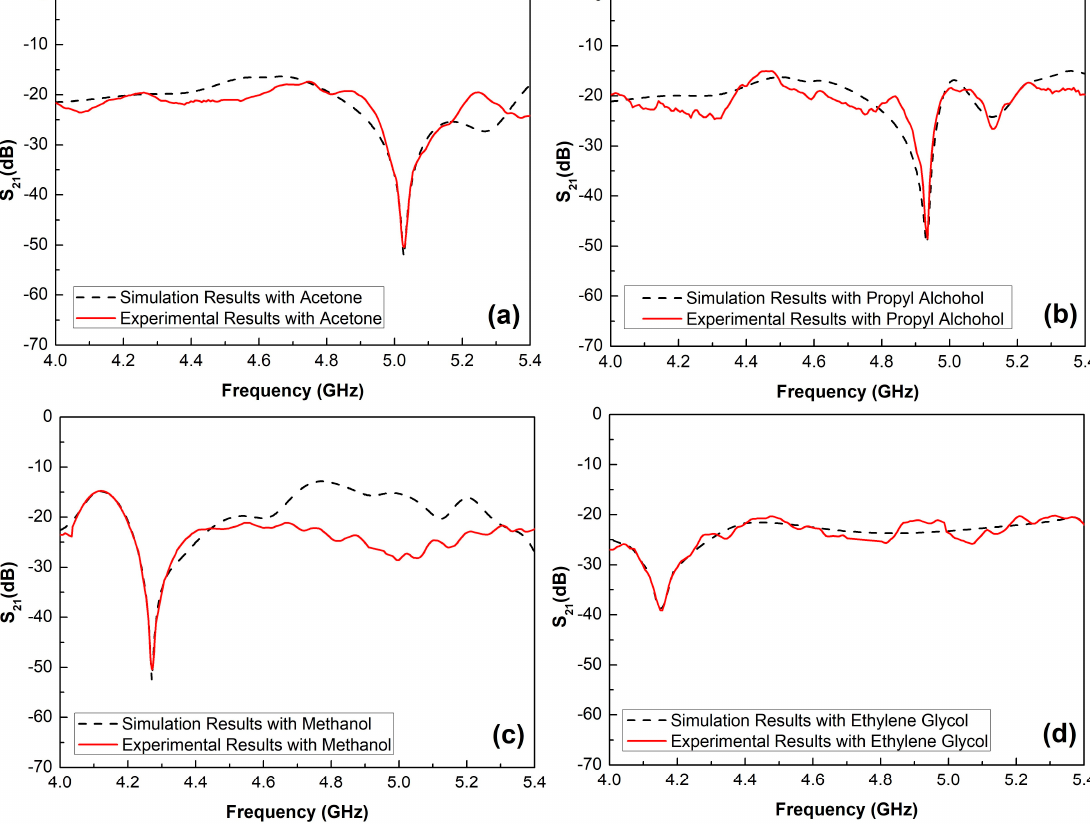
Figure 3. Simulated and experimental results obtained for ( a ) Acetone ( ε = 20.7), ( b ) propyl alcohol ( ε = 21.8), ( c ) methanol ( ε = 33.1) and ( d ) ethylene glycol ( ε = 37).